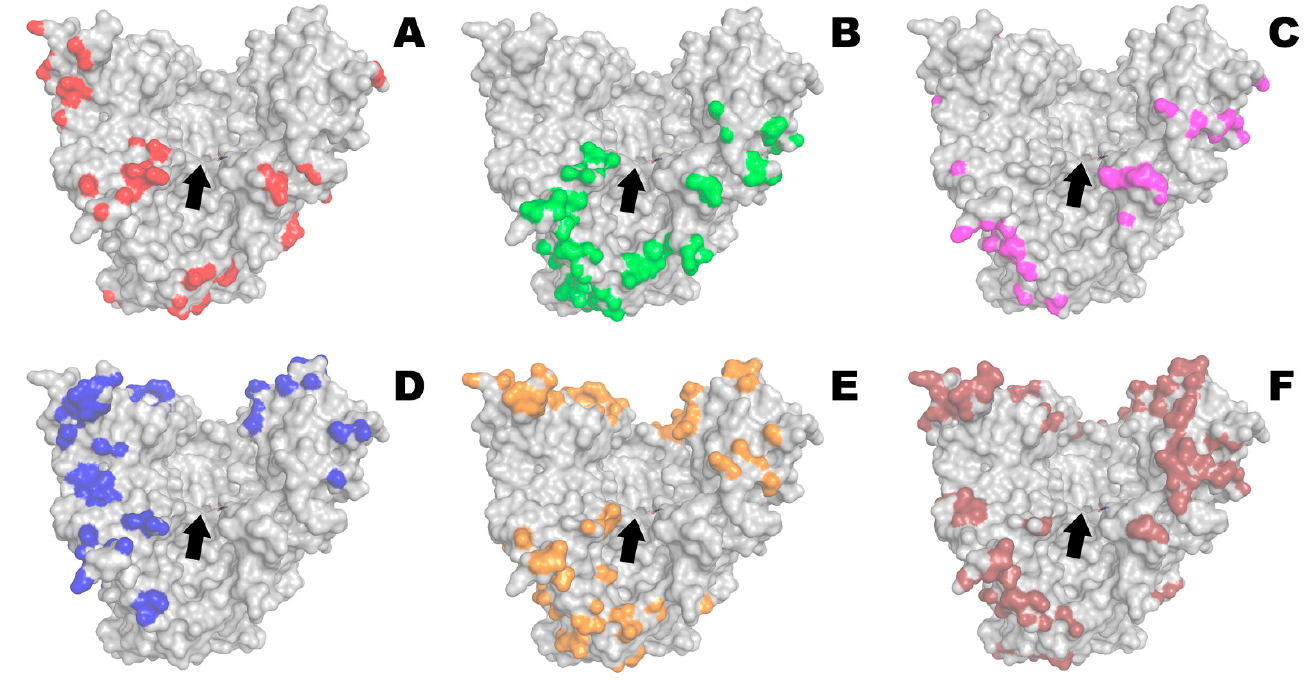
Figure 1. Domains of PvdQ (PDB 4m1j) covered by PLE 50 ( A ), PLD 50 ( B ), PEG-PLE 50 ( C ), PEG-PLD 50 ( D ), PLE 50 -PEG-PLE 50 ( E ), and succinylated gelatin (gelofusine) ( F ), and thus capable of interacting with them within enzyme–polyelectrolyte complexes. The entrance into the active site is highlighted by the arrow; it localizes in the hollow of the V-shaped protein molecule, being slightly tilted forward in the figure for illustration purposes.